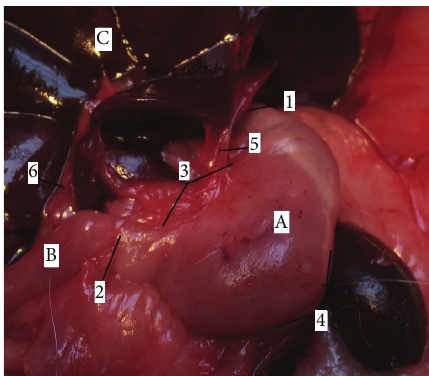
Figure 1: Morphology of rat stomach ( facies parietalis ). 1: pars cardiaca , 2: pars pylorica , 3: curvatura ventriculi minor , 4: curvatura ventriculi major , 5: lig. hepatogastricum , 6: ductus hepaticus com- munis , A: ventriculus ( facies parietalis ), B: duodenum , and C: facies visceralis hepatis